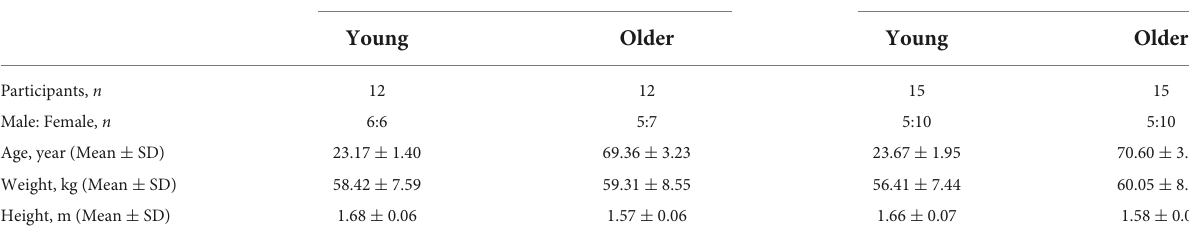
TABLE 1 Demographic characteristics of